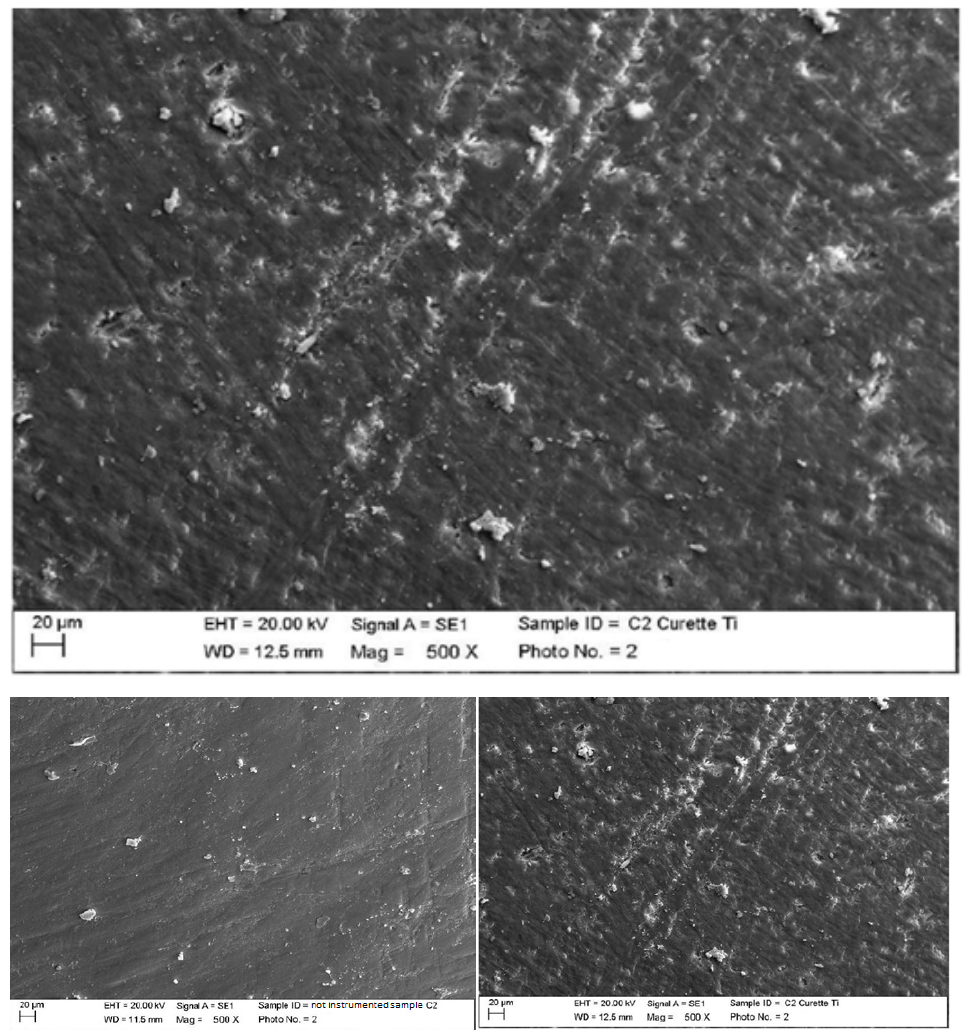
Figure 9. Instrumented composite sample C2 with titanium curette (500×). Comparison before/after instrumentation.